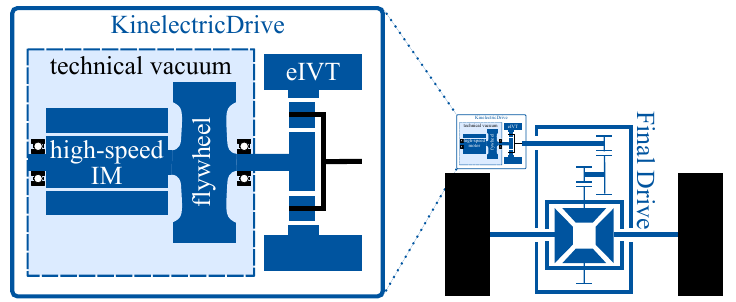
Figure 5. Schematic layout of the “KinelectricDrive” according to